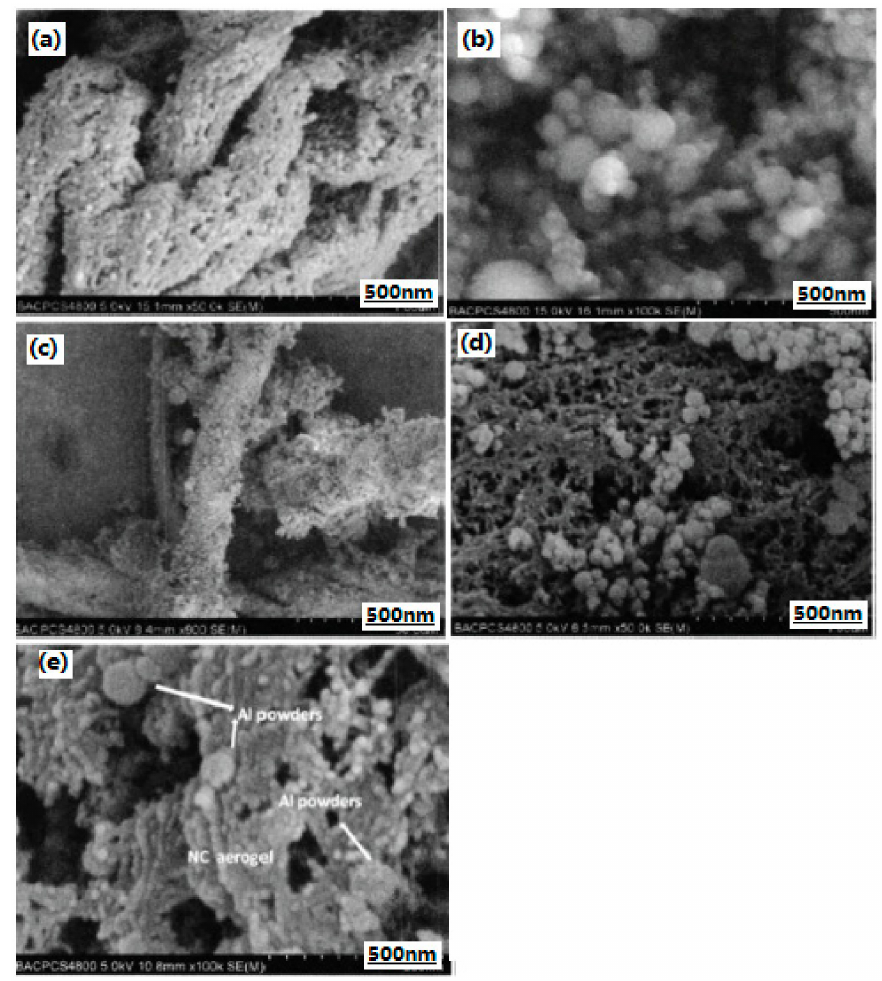
Figure 3. SEM images of di ff erent composite samples. ( a ) NC aerogel; ( b ) Al powder; ( c ) Al / NC mixture; ( d ) NC aerogel / Al mixture; and ( e ) Al / NC nano-sized composite. Reproduced from [33], with permission from Han Neng Cai Liao, 2013.